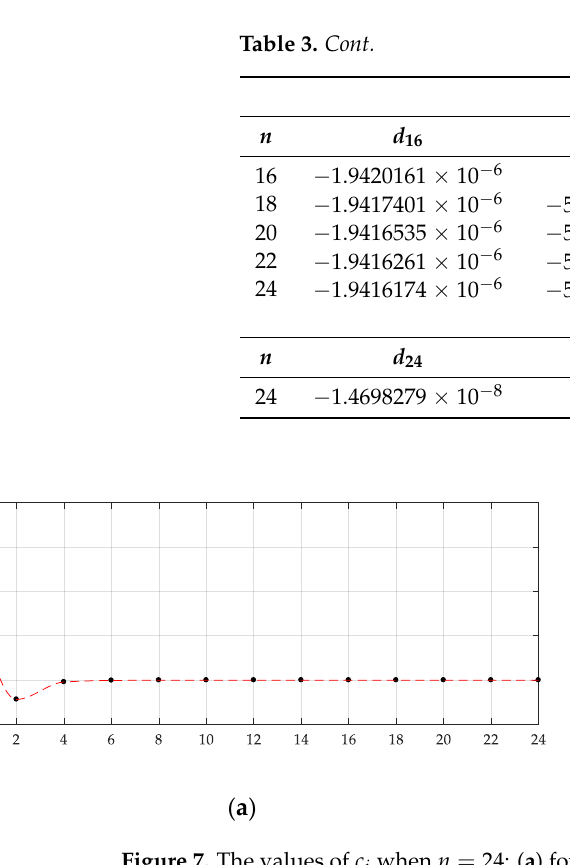
c with n . c with n . 0 0